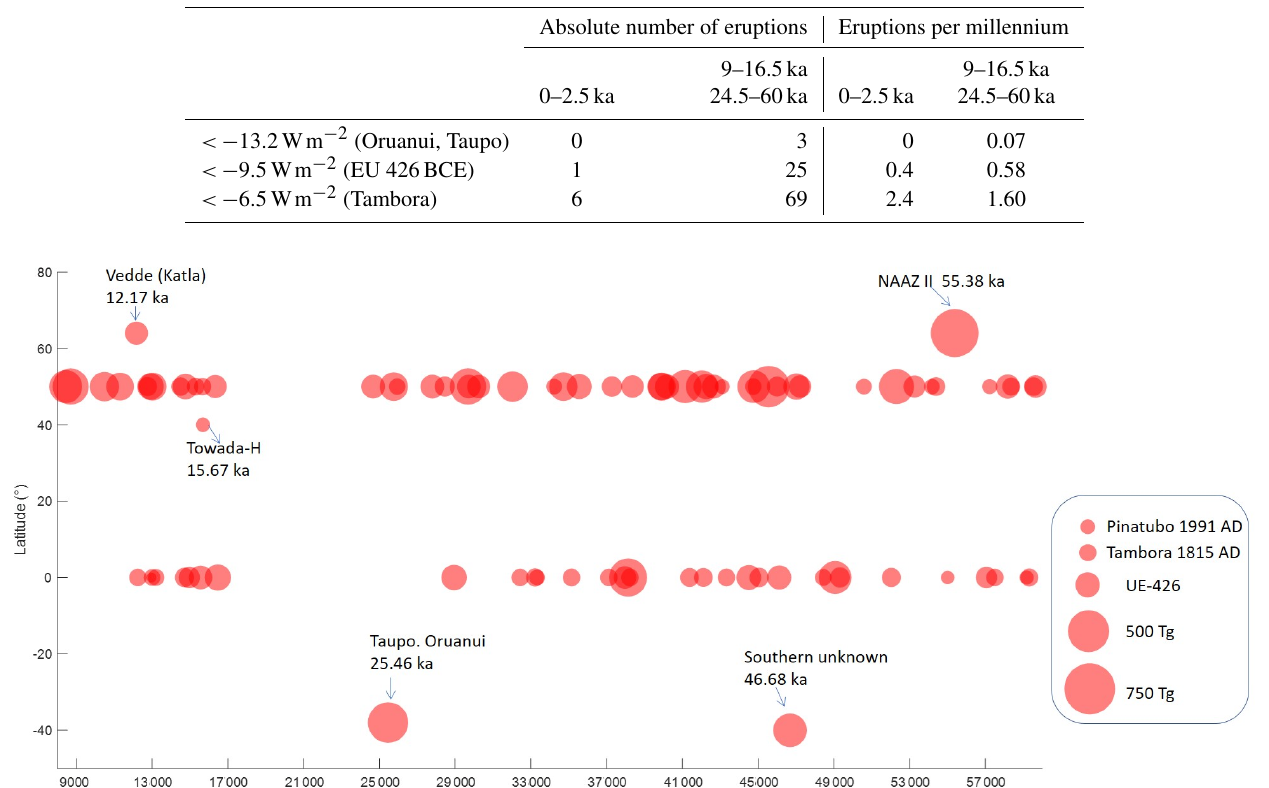
Table 1. The number and frequency of large bipolar volcanic eruptions for the last 2500 years and for the last glacial and early Holocene (this study). The climate forcing is calculated using the SAOD scaling of Aubry et al. (2020) and the radiative forcing conversion from Marshall et al. (2020).